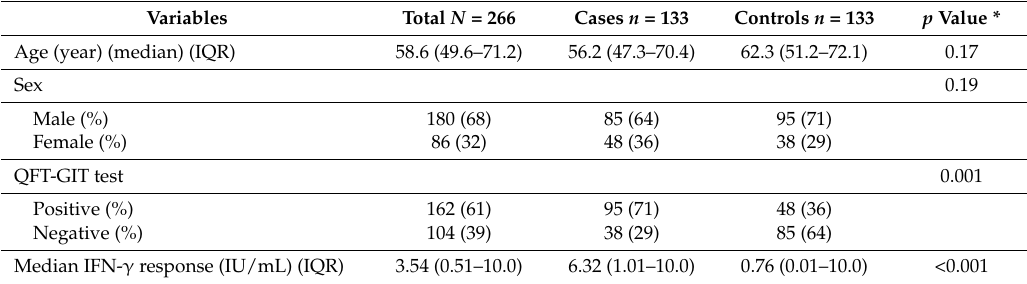
Table 1. Demographic characteristics of the study subjects in Chest Hospital, Taiwan.